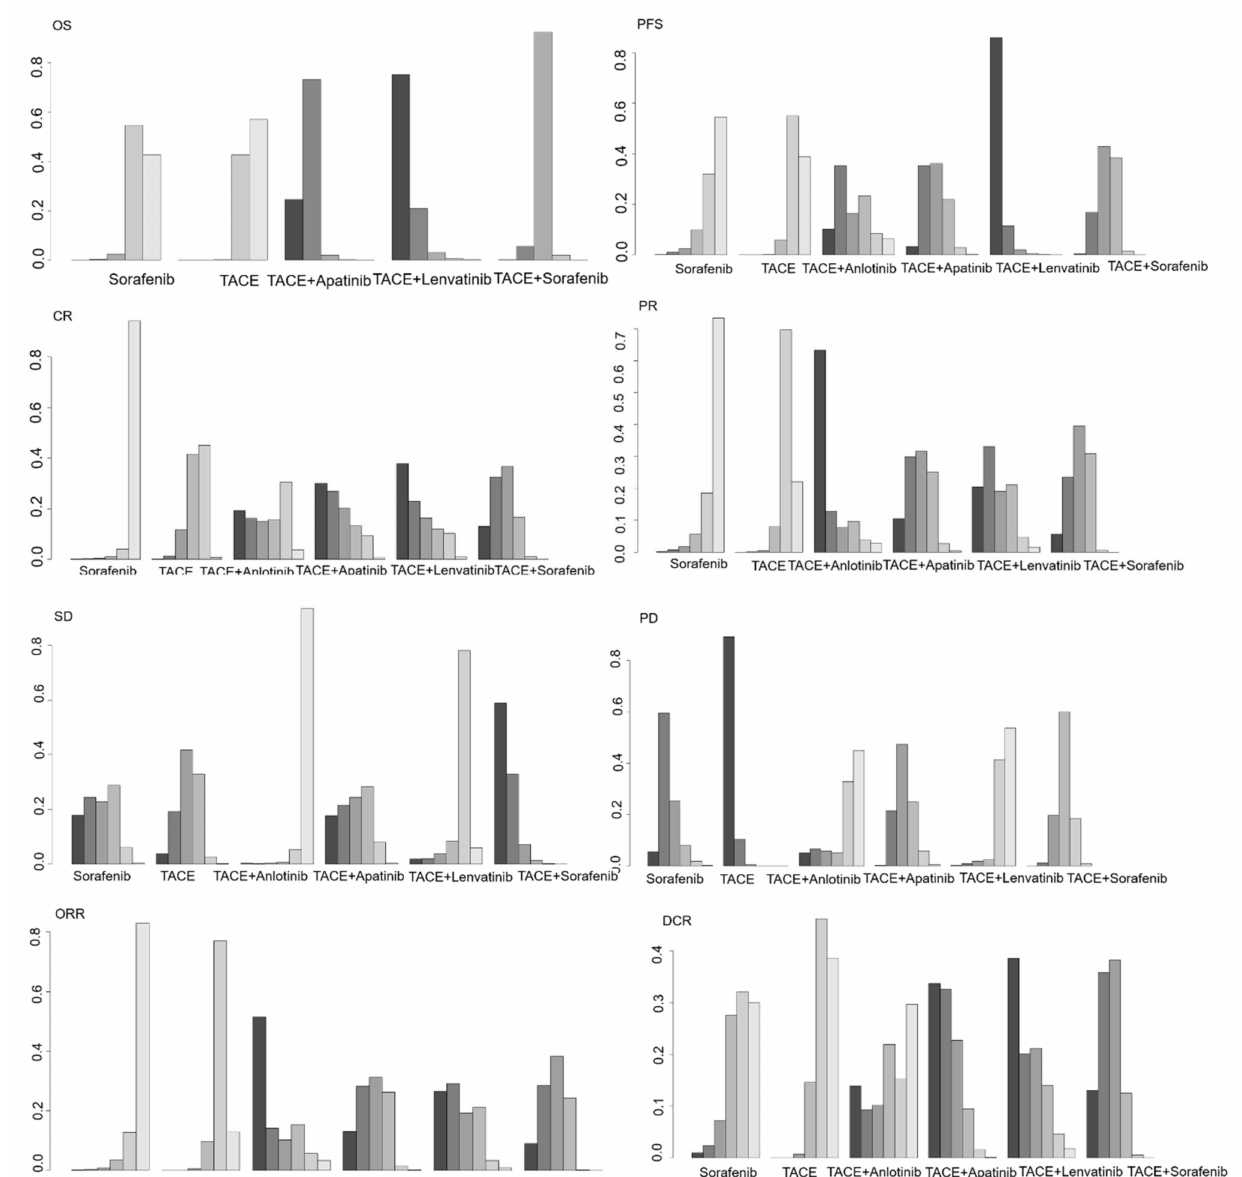
Figure 2. Ranking probabilities of intervention in the studies. The dark-to-light color indicates the rank order. The size of the bar corresponds to the probability of interventions in each